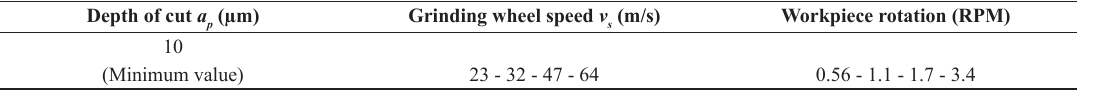
Figure 2. a) Measurement of machined workpieces; b) 1-Cast iron plate. 2-Logitech diamond smoothing block 5 ‘’ in diameter composed of pellets with 40 µm diamond grains attached to the base. 3-Logitech flat polishing gauge model 1SDG1. c) Polyurethane foam on the plate. Table 2. Capabilities of HKM 63